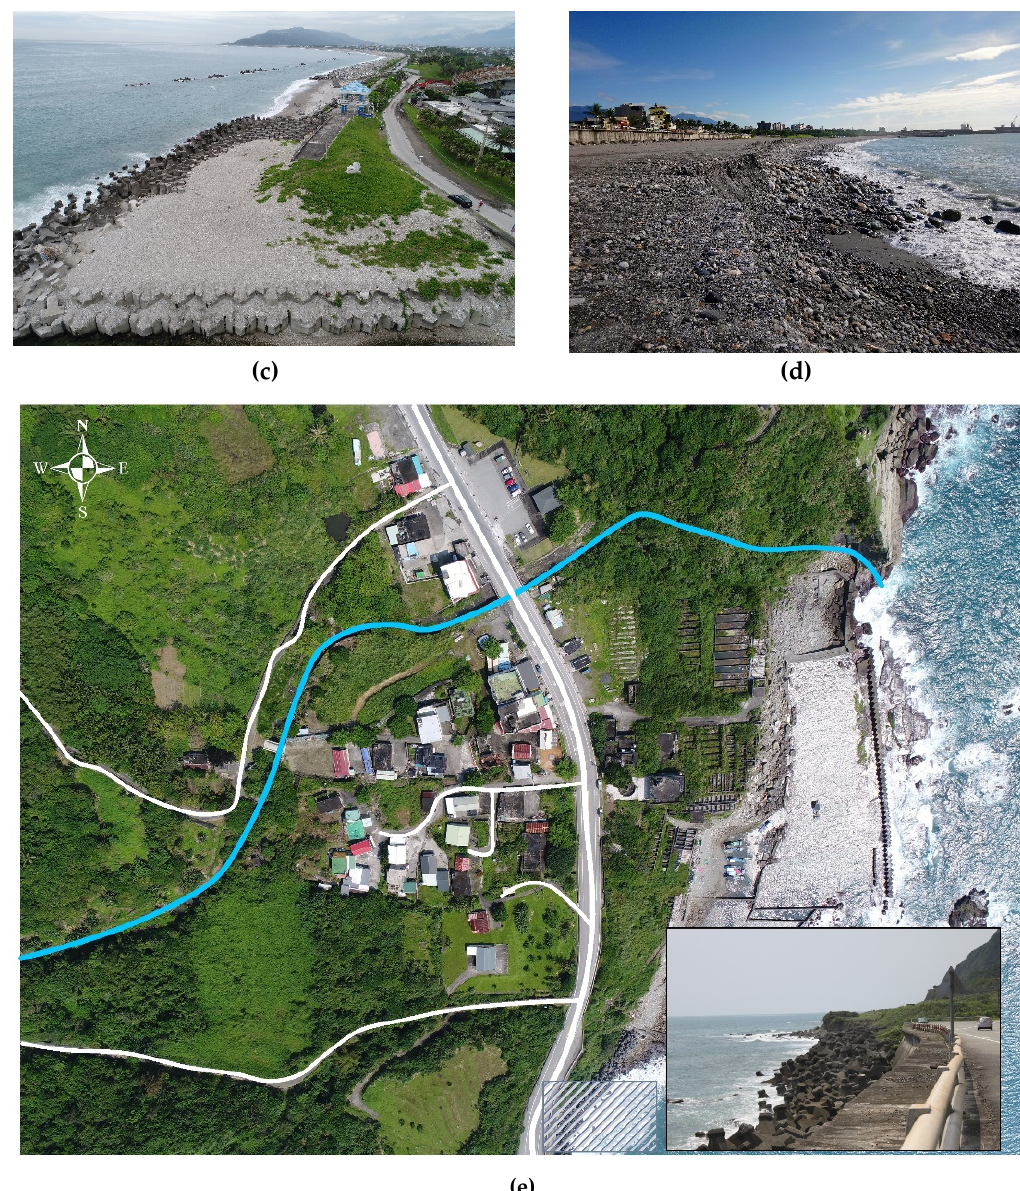
Figure 1. Examples of landscape signs and drone aerial photography survey in coastal settlements. ( a ) large area of planted windbreaks built along the coast; ( b ) coastal landforms due to orographic uplift; ( c ) multilayer concrete or offshore breakwaters; ( d ) erosion scarps along the shoreline; ( e ) several bank revetments that seem to be newly built